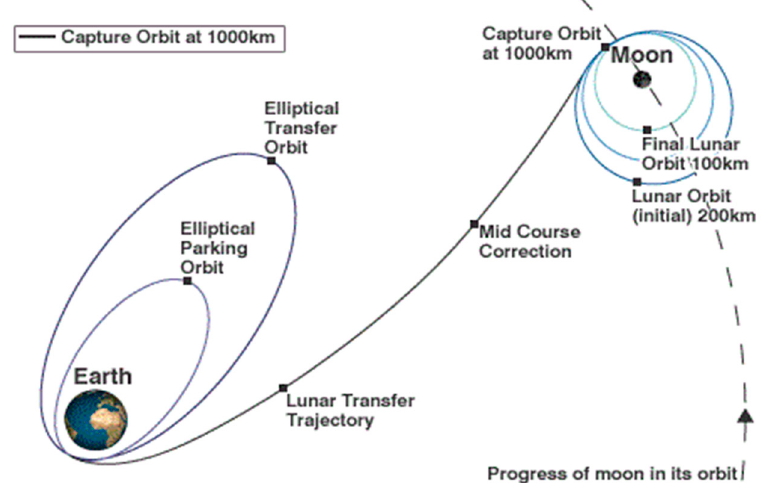
Figure 5. LOCI Low Lunar Orbit insertion.